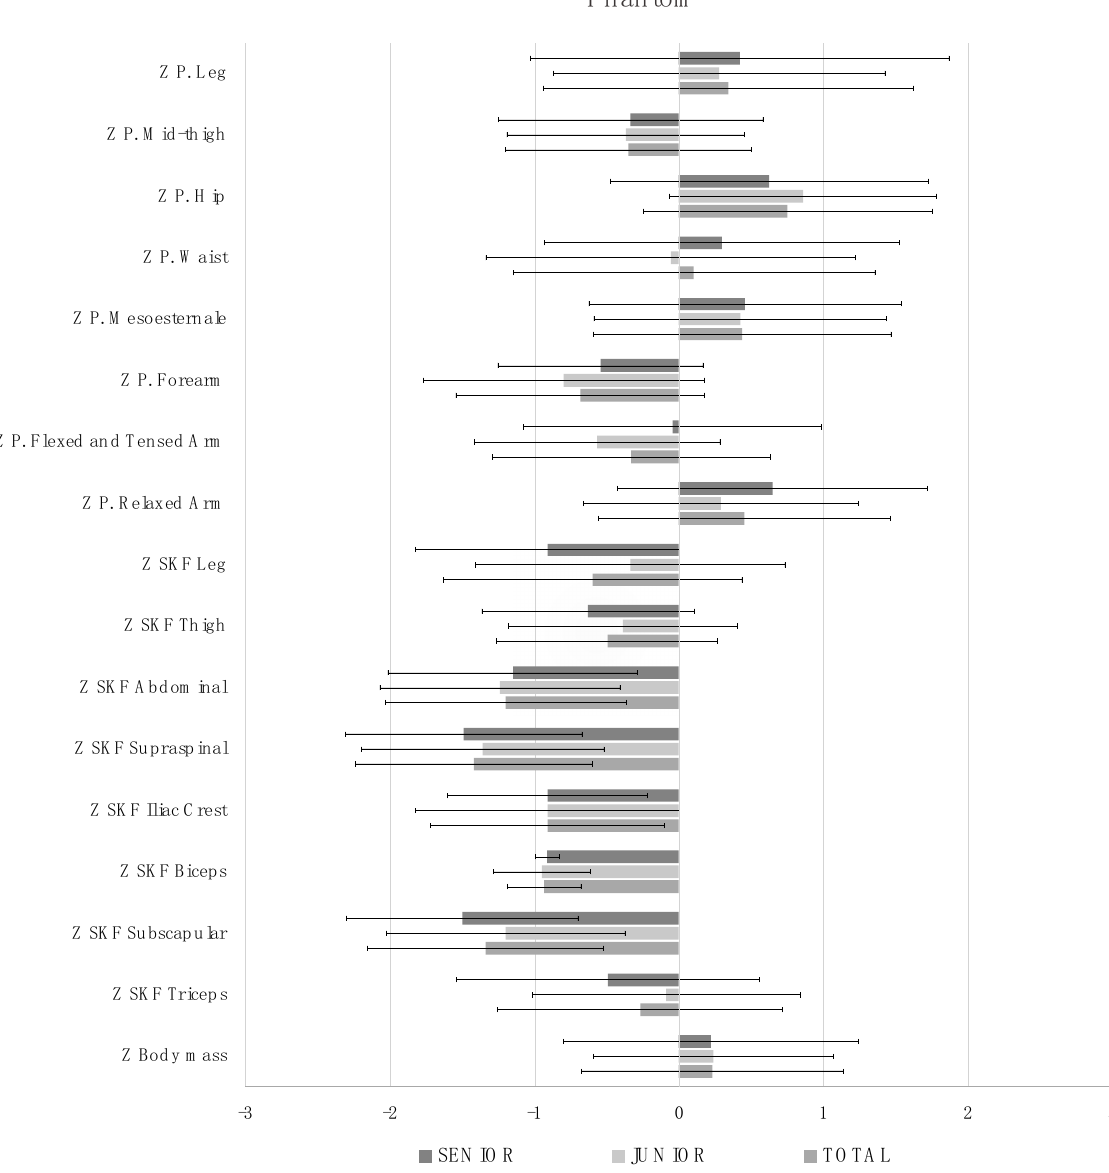
Figure 2. Proportionality with respect to the mannequin of the variables included in the ISAK restricted profile. SKF = skinfolds; P = perimeters.